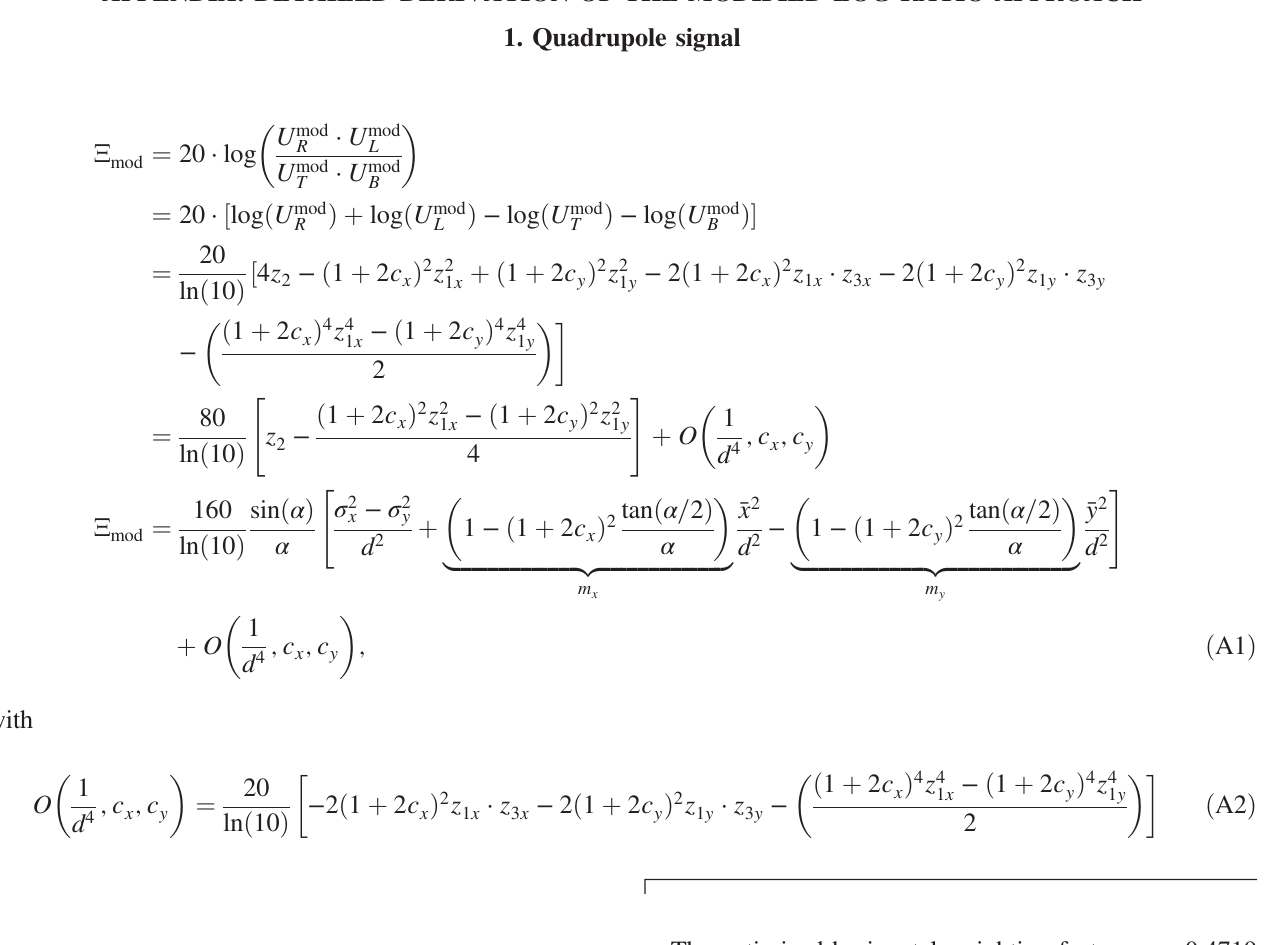
was determined as the arithmetic mean of all values of c x in Table II. The vertical damping factor c y ¼ 0 . 1177 was obtained analogously.